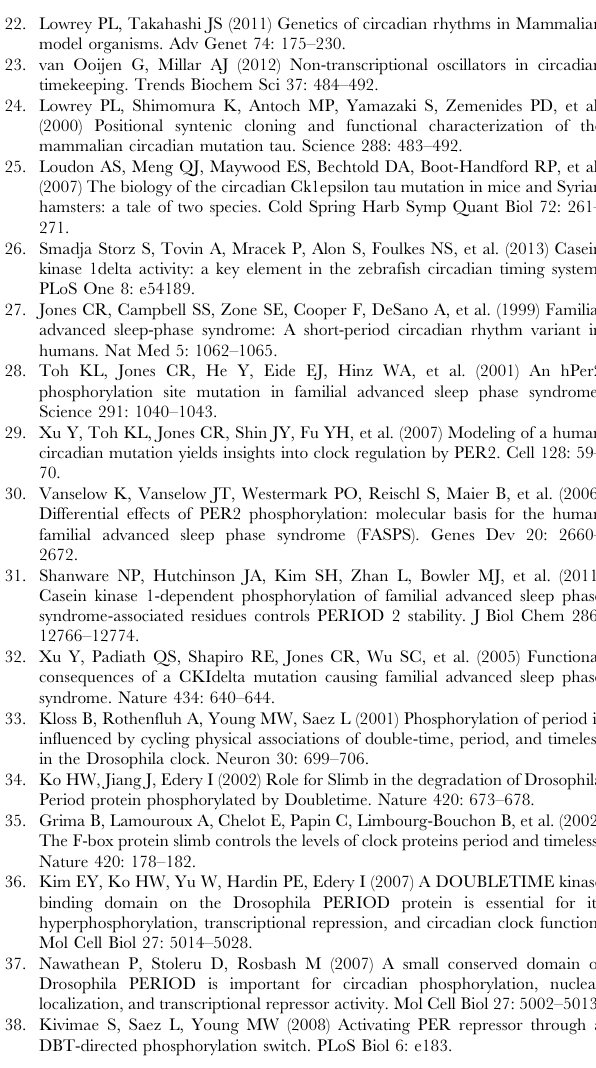
Figures. The table shows genotypes, number of flies tested, the rhythmic fraction of flies tested, rhythmicity index, and circadian